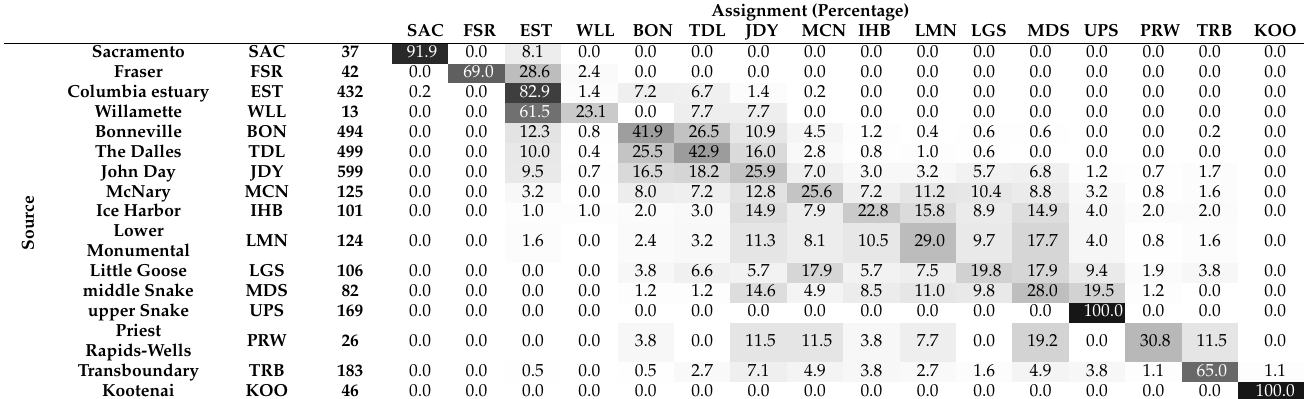
Figure 2. Bar blots from individual-based analyses of white sturgeon. Labels follow Table 1. ( A ) S TRUCTURE analysis with k = 2, with color of each bar reflecting admixture proportions. ( B ) Discri- minant analysis of principal components made with A DEGENET , k = 7, with the color of each bar reflecting proportional assignment success to cluster from cross-validation. ( C ) Population assign- ment, with color of each vertical bar representing assignment from likelihood ratio, made with G ENODIVE . Bars below each block represent the color reflecting assignment to that reach, while the color of each bar reflects the reach to which each individual was assigned. The proportions of each color in each block are reflected by rows in Table 2. Table 2. Rates of population assignment of white sturgeon by reach, with source listed vertically and assigned reach horizontally. On-diagonal elements reflect the proportion of fish assign back to source reach. Off-diagonal elements reflect the proportion of fish that were assigned from the reach indicated by the row name to the reach indicated by the column heading. Sample size for each reach is indicated in the third